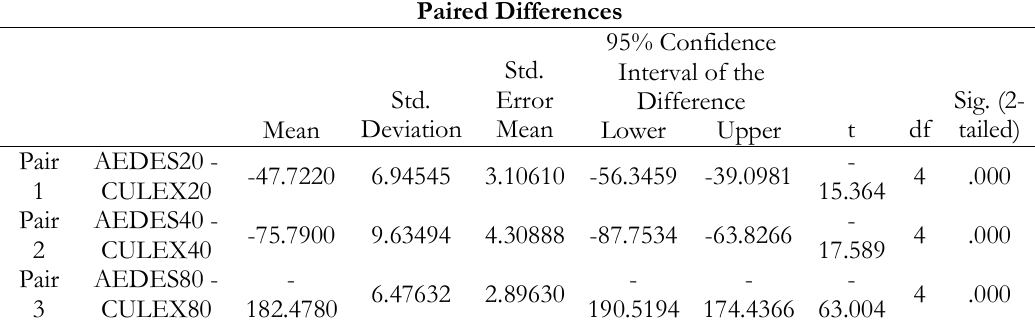
Table IV. Paired t-test comparing reppllency effectivity of citronella oil lotion between Culex sp. and Aedes